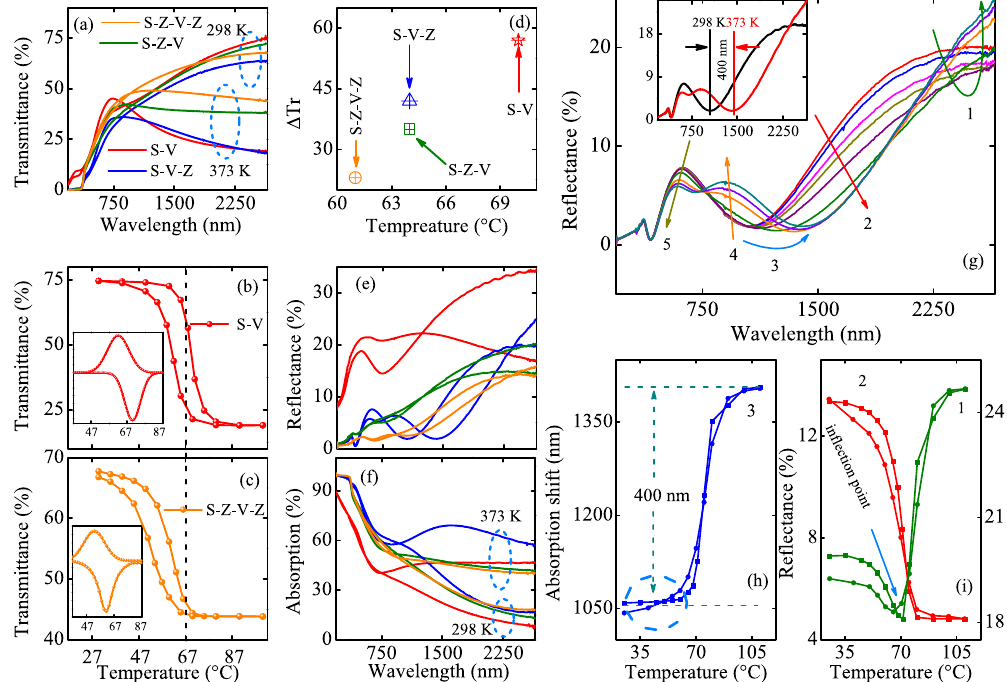
Figure 2. ( a – c ) The low and high temperature transmittance, hysteresis loops and differential curves for the structures. ( d ) The relationship of the T MIT and Δ Tr. ( e , f ) The low and high temperature reflectance and absorption. ( g ) The temperature dependent reflectance for the S-V-Z. The inset is the red-shift of the wave. ( h , i ) The hysteresis loop of the region marked by 1–3 in figure ( g ).